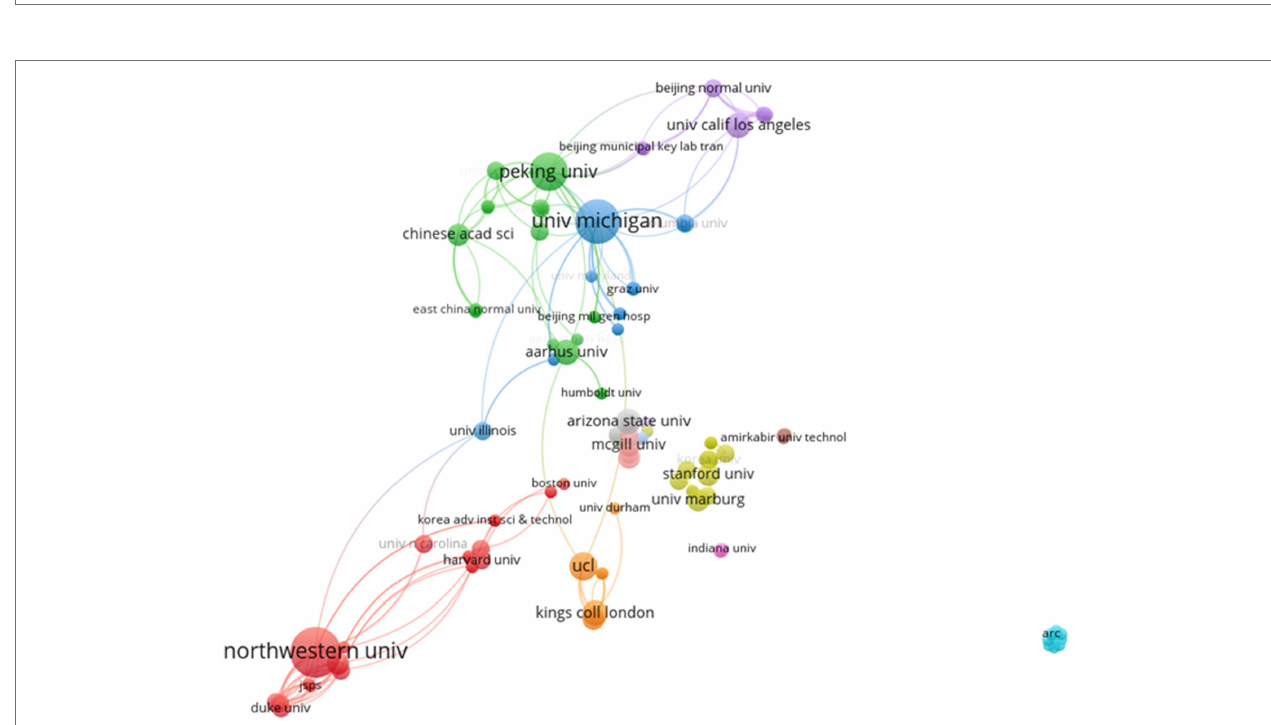
FIGURE 3 | Institution collaboration